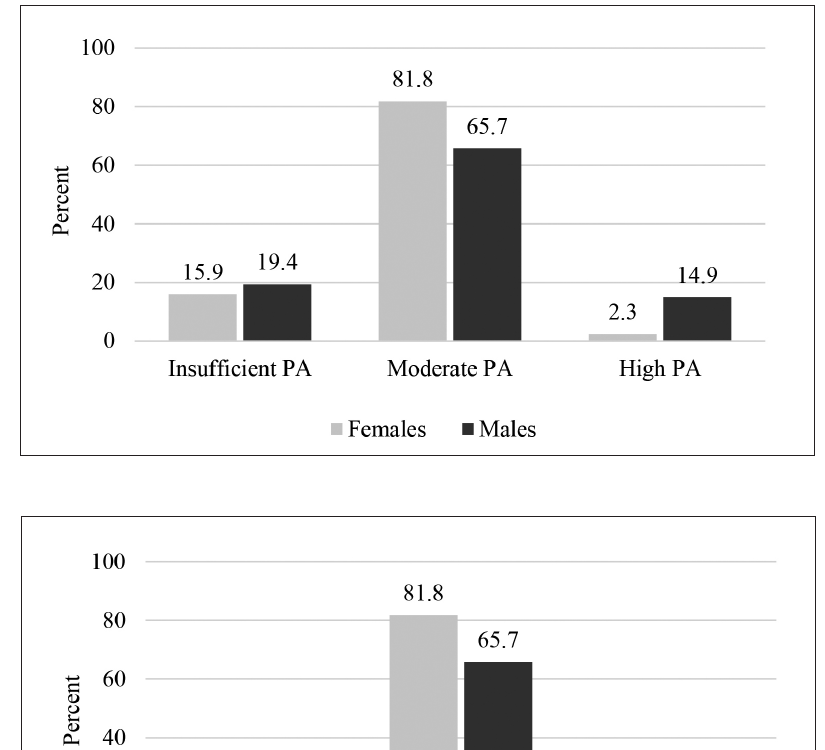
Figure 1. Physical activity